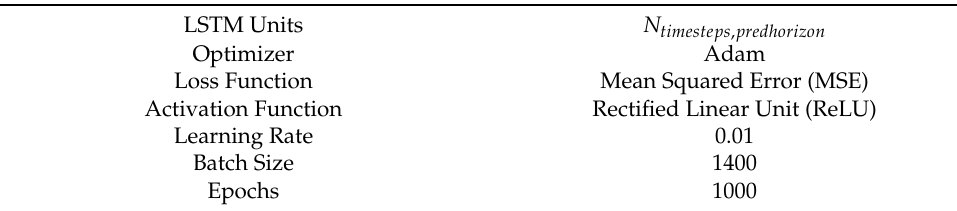
Table 1. Parameters for RNN for 10 s Table 1: Parameters for RNN for 10 s prediction